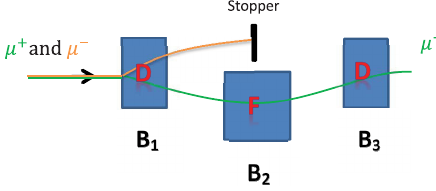
FIG. 14. Schematic of the μ þ = μ − selection.